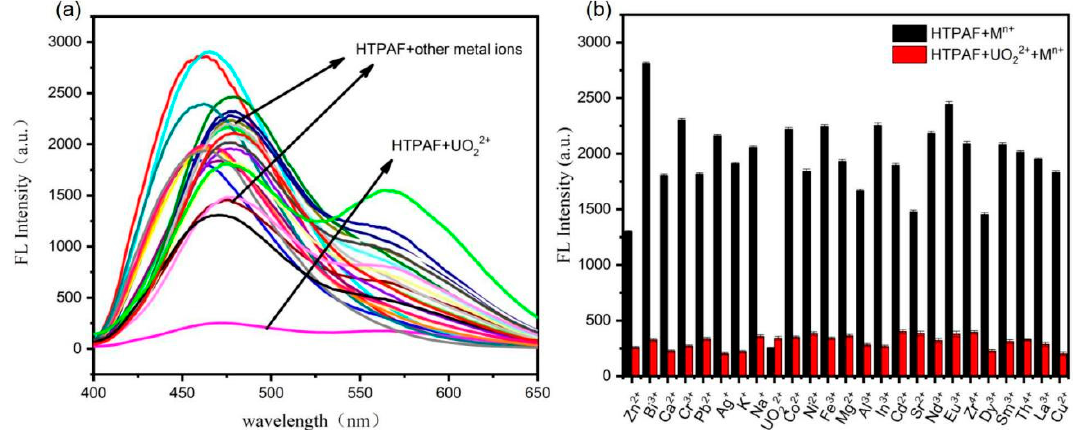
Figure 6. ( a ) Changes in fluorescence intensity of fluorescent probe HTPAF (10 µ M) when an equivalent amount of metal ions (10 µ M) was added ( b ) HTPAF (10 µ M) versus UO 2 2+ (10 µ M) (DMSO:H 2 O = 5:95 v / v and pH = 4.5) selectivity and anti-interference.